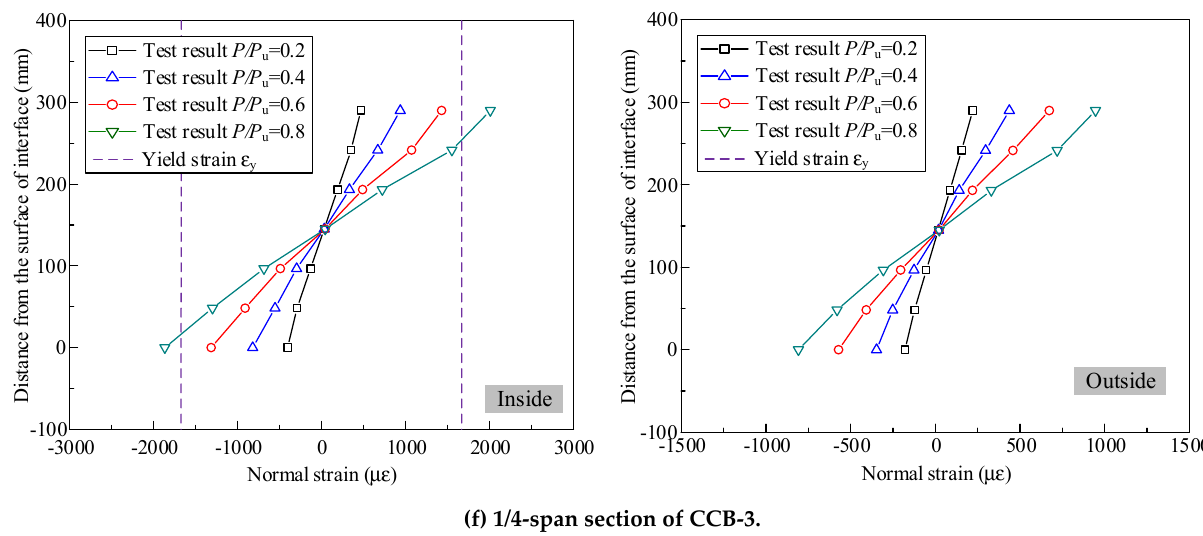
Figure 13. Normal strain distributions of the steel webs of the test specimens.